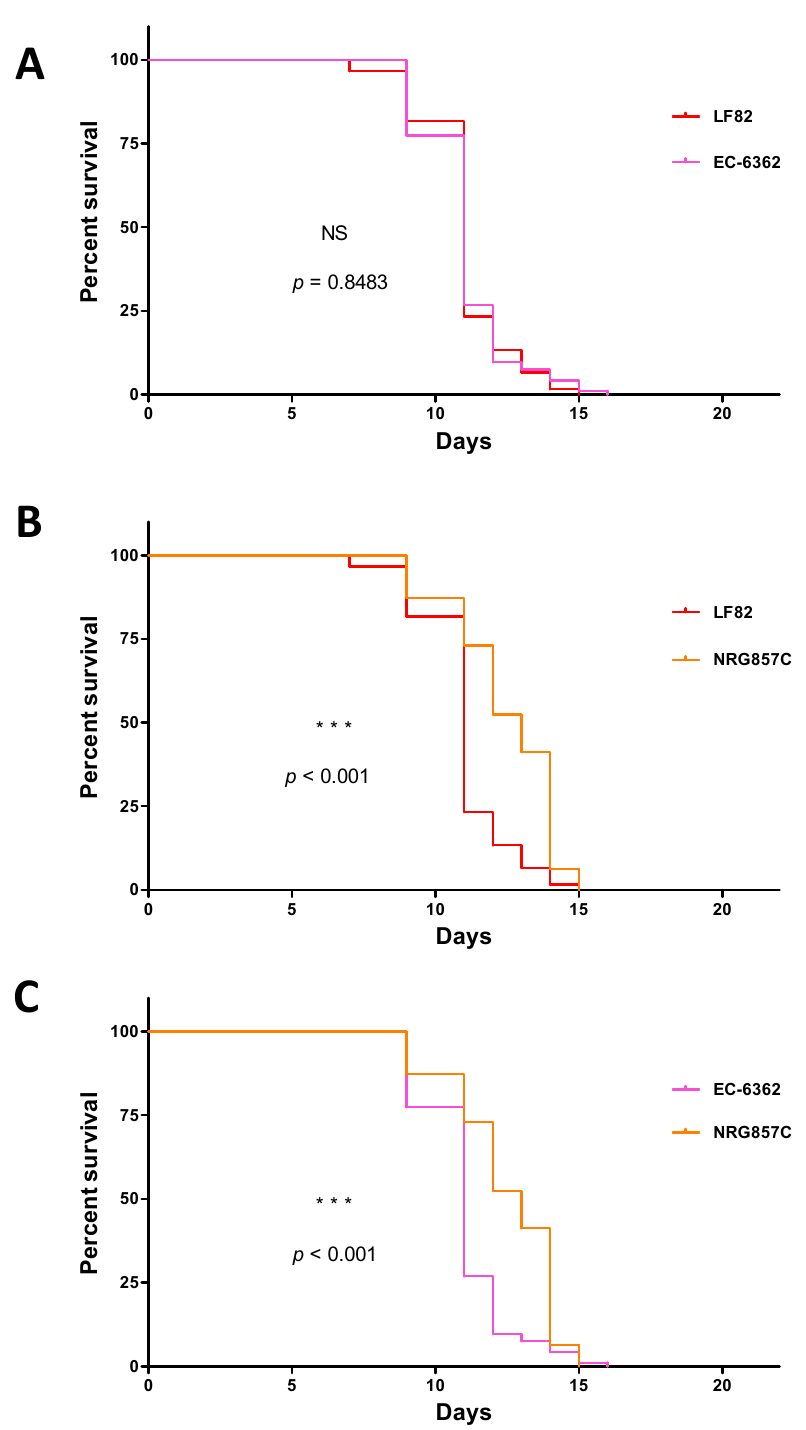
Figure 3. Pairwise comparisons of C. elegans lifespan-modulating effects of E. coli strains. The “ n ” values in brackets correspond to the initial number of larvae investigated for each bacterial strain ( A ) LF82 ( n = 78) vs. EC-6362 ( n = 101). ( B ) LF82 ( n = 78) vs. NRG857c ( n = 65). ( C ) EC-6362 ( n = 101) vs. NRG857c ( n = 65). The statistical significance of intergroup differences was assessed with a log-rank (Mantel-Cox) test; ***: p < 0.001; NS: not significant).